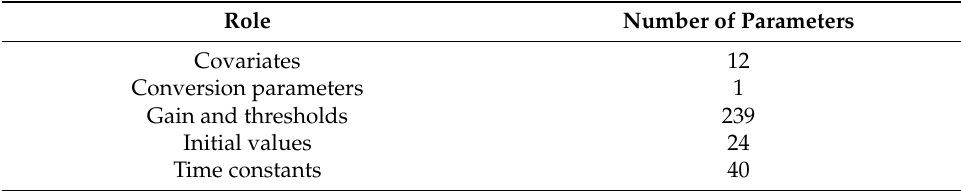
Table 2. Distribution of the model parameters according to their role. Role Number of Parameters Covariates Conversion